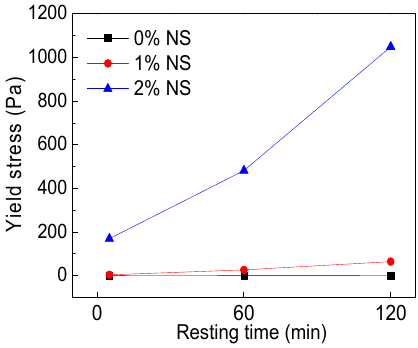
Figure 8. Influence of resting time on τ 0 . Table 4. Rheological parameters of C–FA paste with NS.